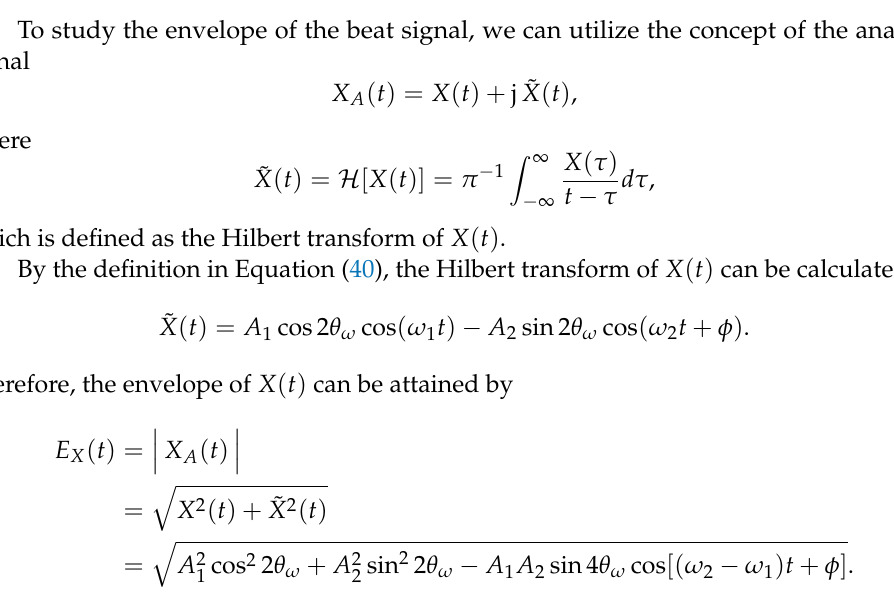
Figure 9. The beats in X ( t ) and the Hilbert transform of X ( t )